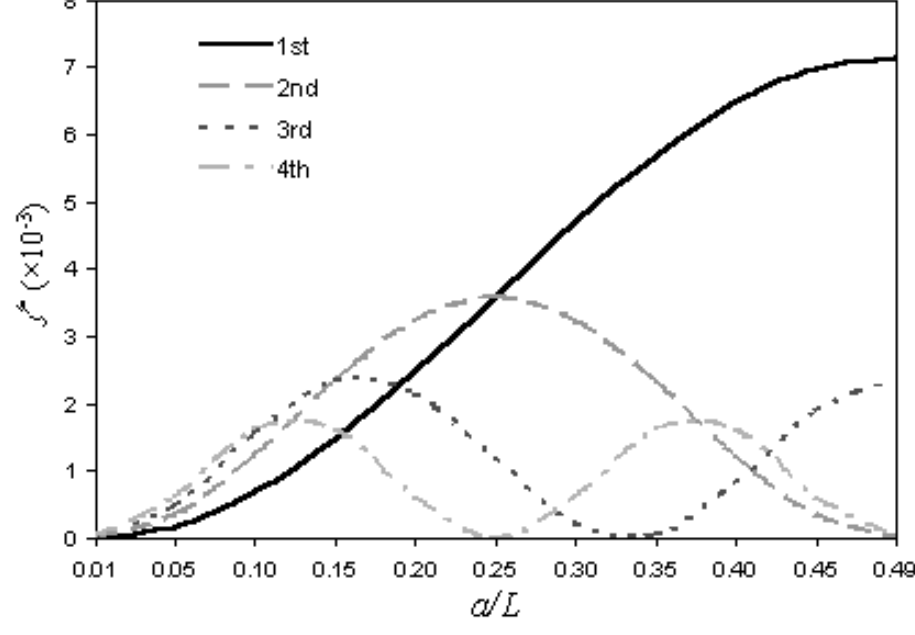
Fig. 2. Damping ratios versus damper locations for the first four eigenfrequencies of locally reacting